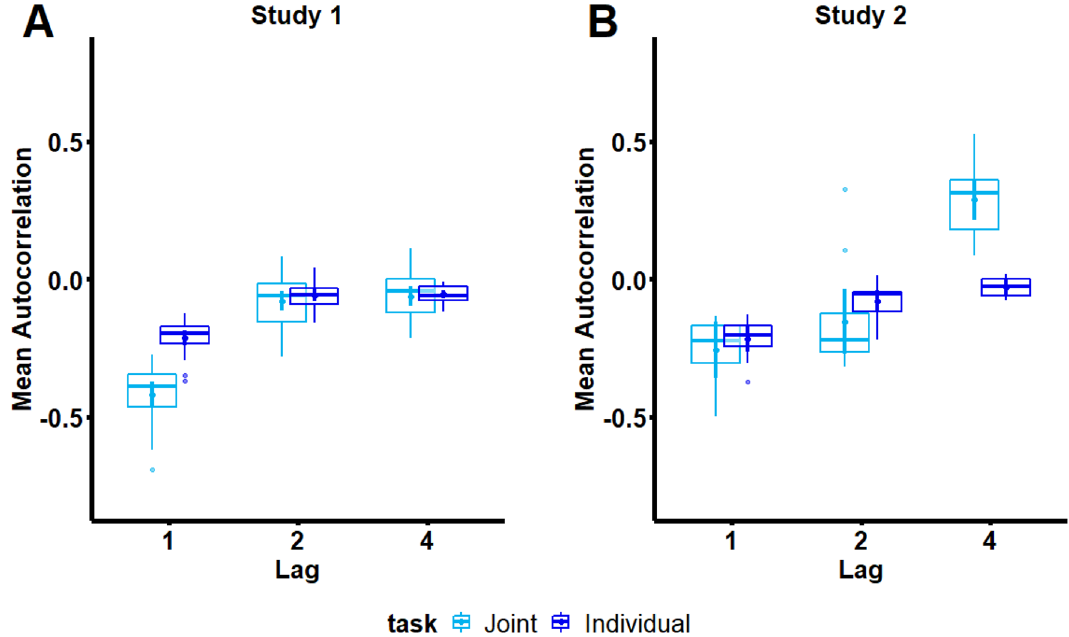
Figure 3. Autocorrelations at lags related to turn-taking. Boxplots displaying mean autocorrelations at lags 1, 2, and 4 for Study 1 (Panel A) and Study 2 (Panel B) for Individual (dark blue) and Joint (light blue) tasks. Boxplots display the median of each distribution (horizontal lines), where and lower and upper hinges reflect 25% and 75% around the median, and upper and lower whiskers reflect + /− 1.5 × the Inter-Quartile Interval for the distribution (default statistical settings in geom_boxplot() in the ggplot2 R package, as called from